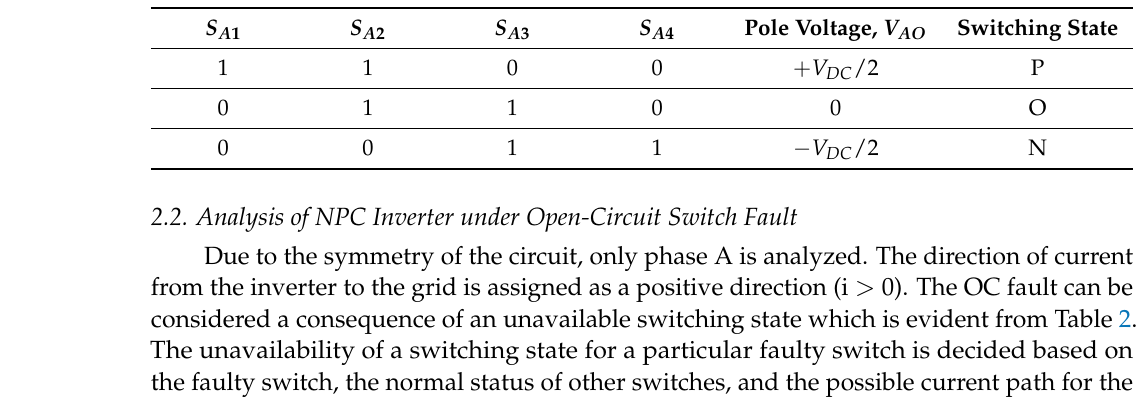
Figure 3. Switching state circuits based on current direction for pole A. ( a ) Switching states P, O, N for i > 0. ( b ) Switching states P, O, N for i < 0. Table 1. Switching states under normal operating conditions.